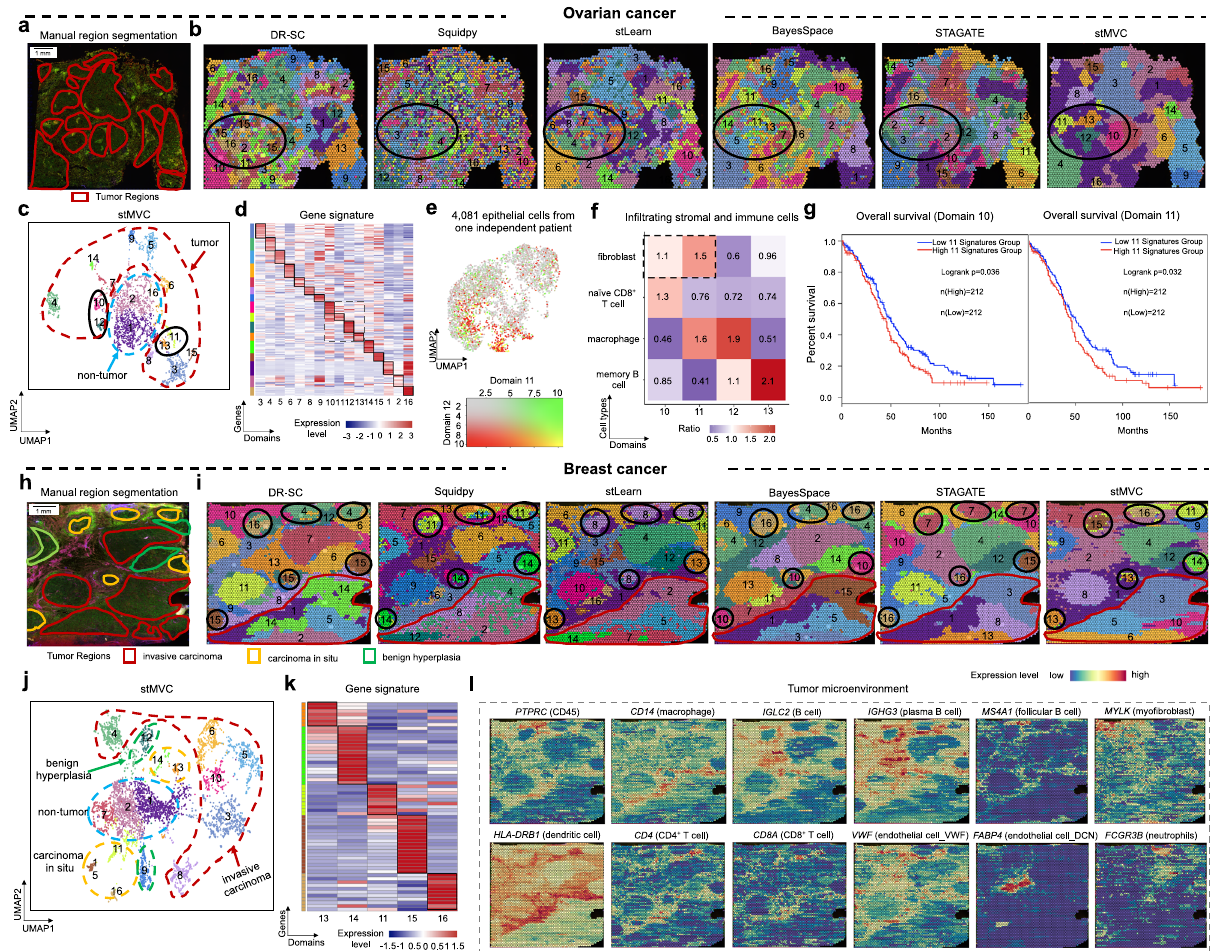
Fig. 3 | stMVC enables the detection of cell-states distributed in different spa- tialdomainsonovarianandbreastcancers.a Immuno fl uorescentstainingofthe tissue section and 17 manually segmented tumor regions. The intensity of DAPI, cytokeratin, and CD45 is shown in blue, green, and yellow. b Spatial clustering by DR-SC, Squidpy, stLearn, BayesSpace, STAGATE, and stMVC. c UMAP visualization oflatentfeaturesbystMVC.Eachdomainisoutlinedbytheregionitbelongsto,i.e., tumor or non-tumor. d Heatmap of average gene expression of signature genes from 16 domains by stMVC. Rows and columns indicate genes and domains. e UMAP plot of average expression of signature genes for domains 11 and 12 in scRNA-seq data of 4081 epithelial cells from one independent ovarian cancer. f Enrichment of in fi ltrating stromaland immunecellsineach domain compared to thetotaldistributionofthoseinfourdomains.Theratioiscalculatedbychi-square test 85 . The larger the ratio, the more cells are enriched in the domain. g Total sur- vival rate of patients with the high (> median value) or low (low < median value)